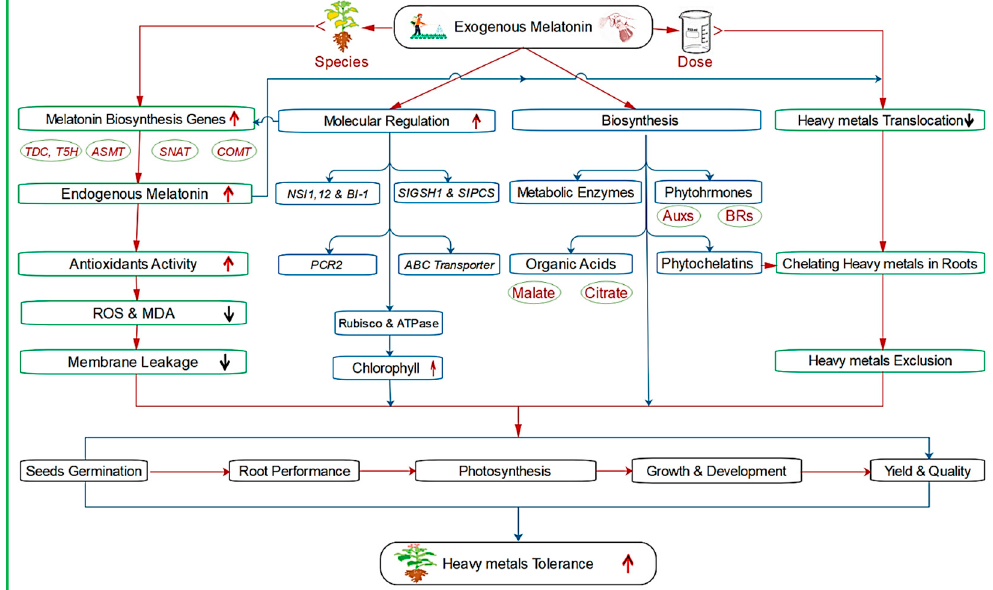
Figure 3. Melatonin induced mechanisms aimed at increasing plant tolerance to heavy metals. The positive effect of MT is species and dose-dependent responses. The exogenous MT induces the endogenous MT via upregulating the biosynthesis genes, which controls the ROS scavenging, molecular elements, biosynthesis, and heavy metal translocation. Moreover, MT regulates the molecular elements such as NS genes (nuclear shuttle protein-interacting), Bl-1 (Bax inhibitor-1 protects against apoptosis), SIGSH1 and SIPCS (responsible for GSH and PCS in tomato), ABC transporter and PCR2 (stress-responsive genes), as well as Rubisco and ATPase (crucial genes to the photosynthesis). Besides, melatonin enhances the biosynthesis of metabolic enzymes, phytohormones (i.e., auxins (AUXs), and brassinosteroids (BRs)), organic acids (root exudates such as malate and citrate), and phytochelatins (chelate the heavy metals (HMs) in roots). Consequently, the whole plant life cycle is improved, starting with seed germination till yield and quality, collectively conferring heavy metal tolerance.